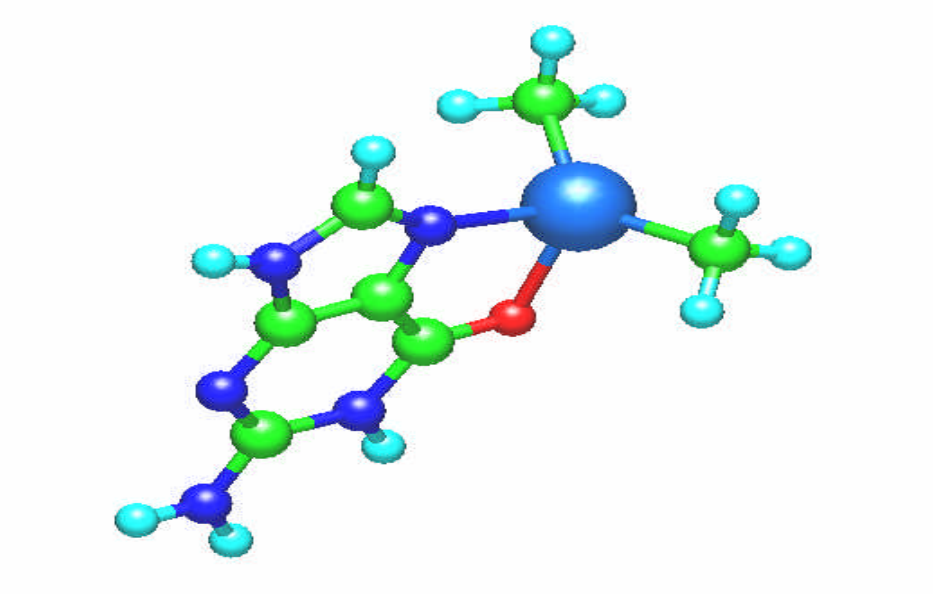
Fig. 2. Molecular structure of the [Sn(CH